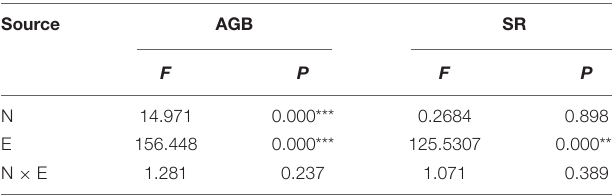
TABLE 2 | Summary of the linear mixed-effects models relating fixed factor (N, E) and random factor (Y) for the grassland above-ground biomass and species